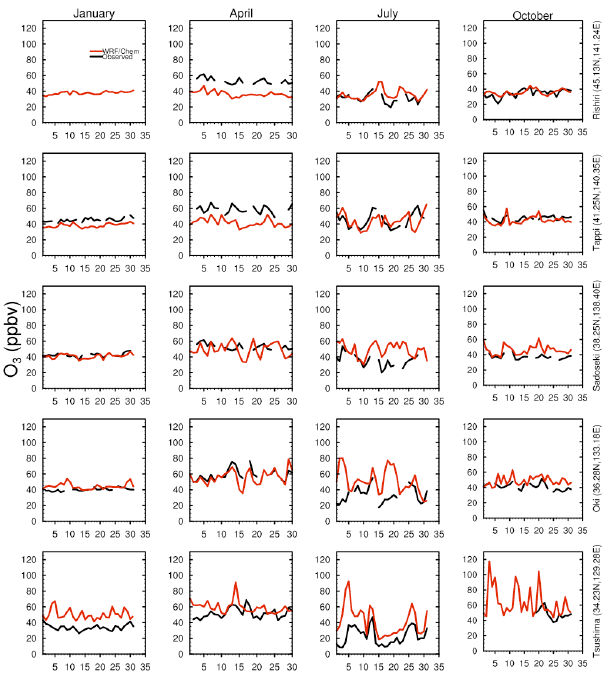
Fig. 4a. Comparison of observed (black) and simulated (red) daily mean O 3 mixing ratios (ppbv) at Rishiri, Tappi, Sadoseki, Oki, and Tsushima. Observed hourly values were taken from EANET data for 2000 and averaged when there was no missing value in 24-h.